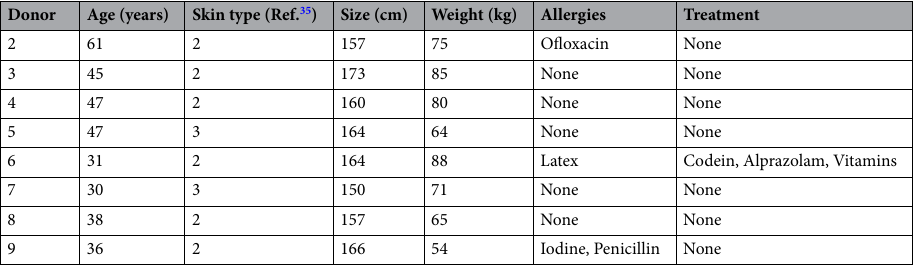
Table 1. Characteristics of skin donors used in this